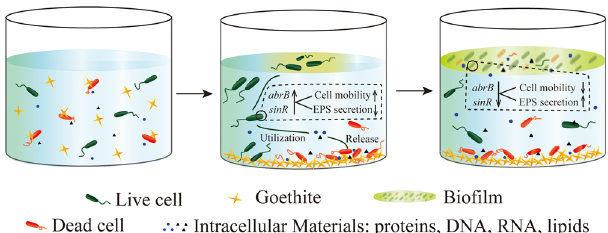
Fig. 5 Proposed model for the effects of goethite on B. subtilis bio fi lm formation. Bacteria interact with goethite in suspension and the adsorption to goethite of bacteria can induce cell damage or death ( left panel ). Live cells utilize the intracellular materials released by damaged or dead cells. In response to lethal stress, the abrB and sinR genes, which are the key to the transformation of bacilli between bio fi lm and free-living mode-of-life, are upregulated and this increase cell mobility and inhibit EPS secretion. In order to avoid damage of goethite, bacteria prefer to move to air – liquid interface ( middle panel ). As bacteria aggregate on the air – liquid interface, both abrB and sinR are downregulated, which decreases cell mobility and increases EPS secretion, and the bio fi lm is formed rapidly ( right panel